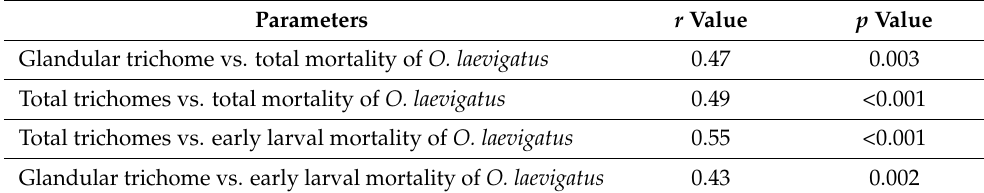
Table 1. Correlation between trichome density and immature O. laevigatus mortality on six tomato genotypes.